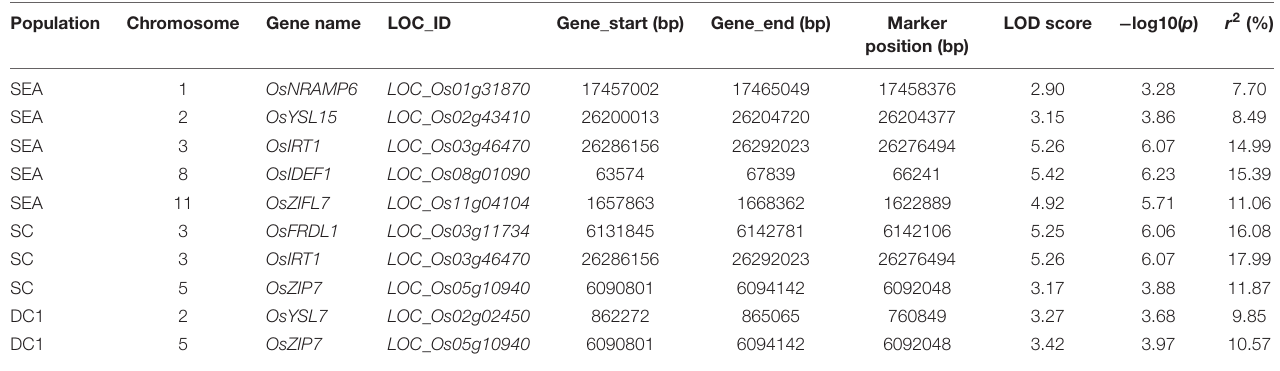
TABLE 2 | List of detected grain Zn content-associated genes in all the panels based on the mrMLM model.